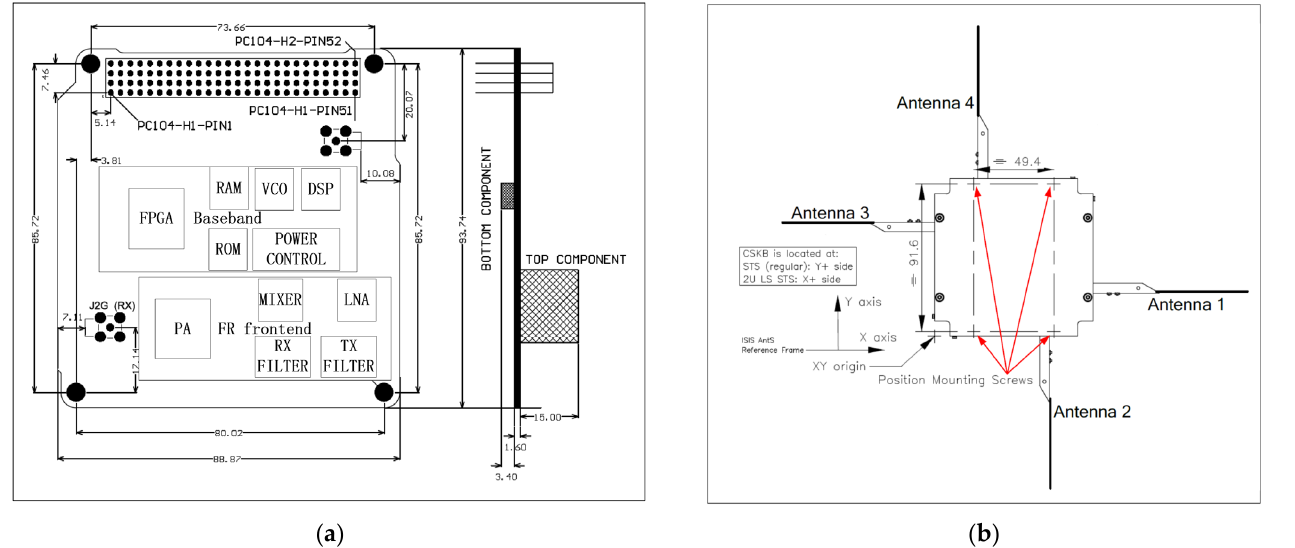
Figure 4. ( a ) UVH transceiver design; ( b ) UVH antenna design.